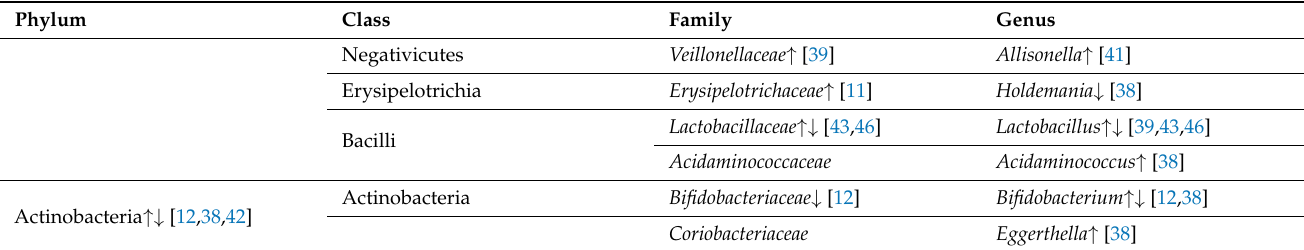
Table 2. NAFLD-associated gut microbiota